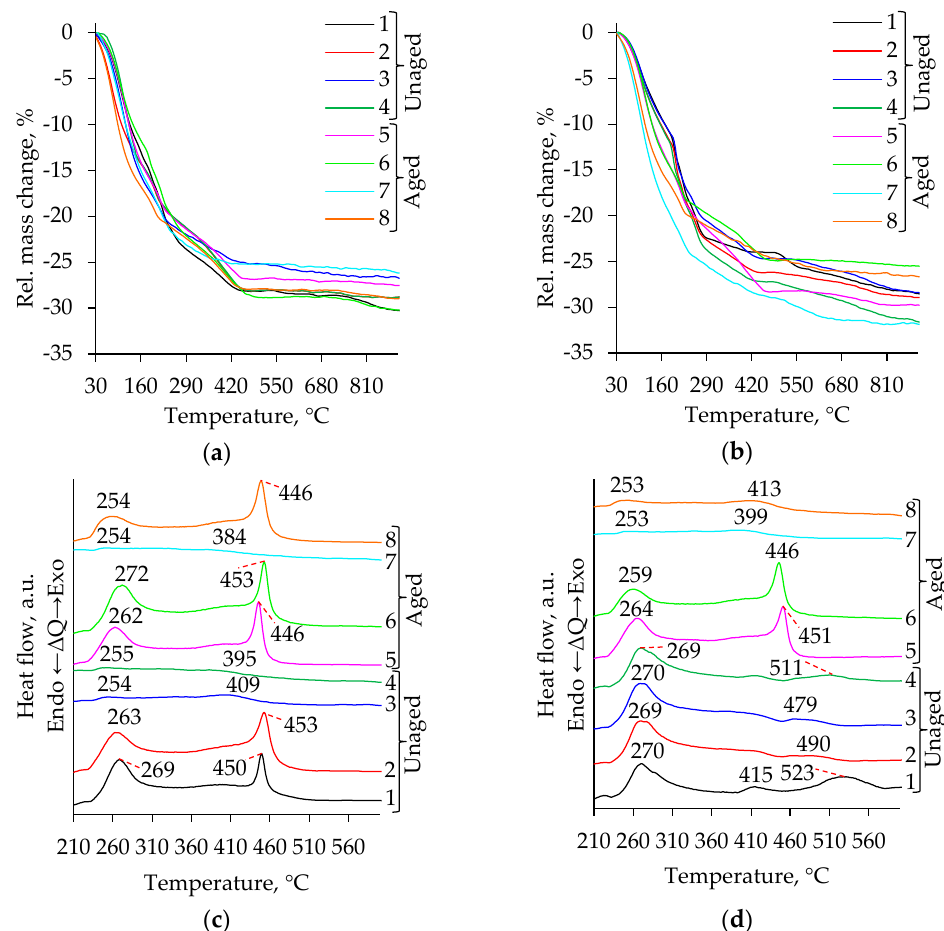
Figure 1. TG ( a , b ) and DTA ( c , d ) curves of TiO 2 aerogels after subcritical drying in dependence of precursor type (TIP ( a ), TBOT ( b )), ageing (without aging ( 1 – 4 ), aged ( 5 – 8 )) and solvent used for additional solvent exchange ( 1 , 5 —without exchange; 2 , 6 —CH; 3 , 7 —nH; 4 , 8 —DE).